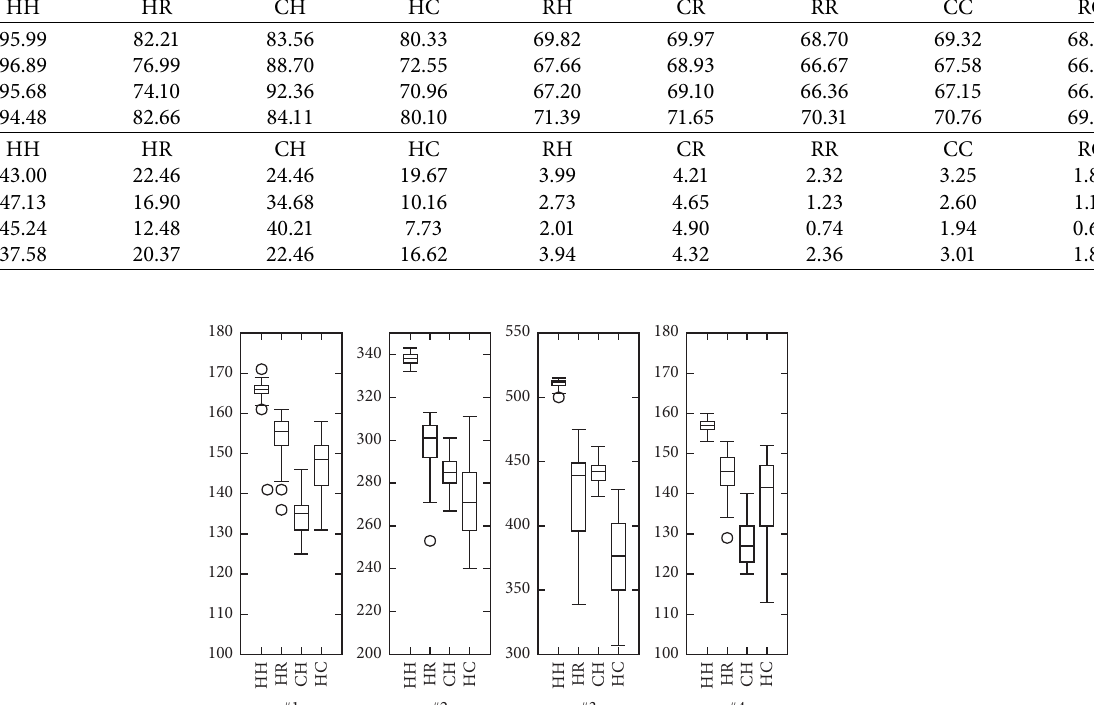
Table 11: Mean percentage qualities of the best-found schedules returned by the LS algorithms (the top table) and mean percentage improvements of the lengths of schedules returned by the LS phase with respect to the lengths of schedules returned by the initialization phase (the bottom table) for each of the four classes of the benchmark given in [7, 8] with cov � 80%. No. HH